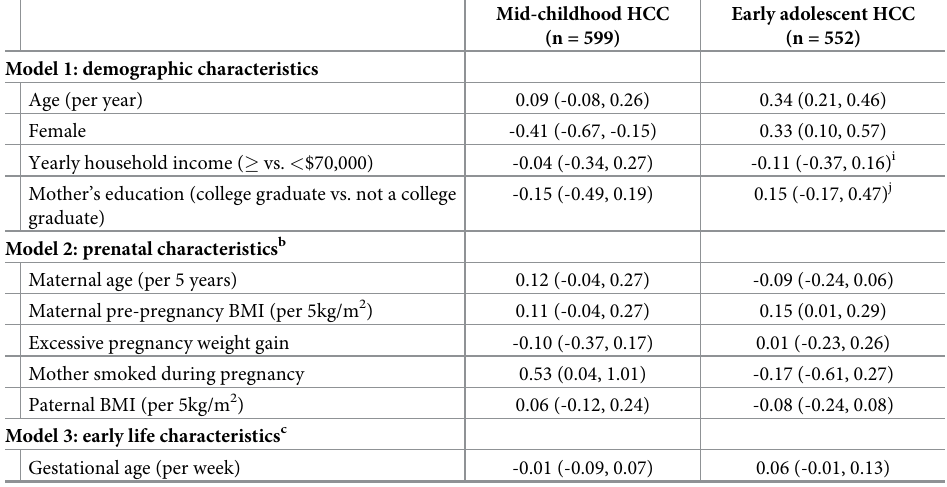
Table 2. Associations ( β [95% CI] i ) of prenatal, parental, and child characteristics with hair cortisol concentra- tion a in White